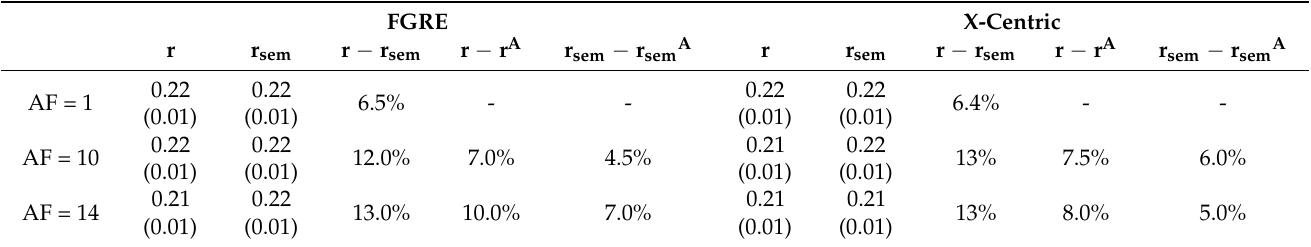
r = MRI mean fractional ventilation estimate obtained with the Deninger method using fully sampled data; r